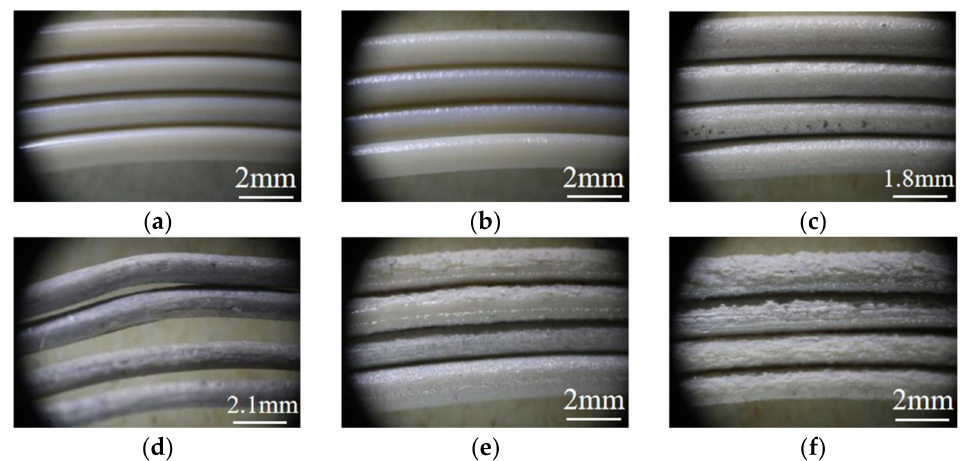
Figure 2. The morphology of the filament corresponding to each sample. The filament corresponds to the following samples: ( a ) Sample 1#; ( b ) Sample 2#; ( c ) Sample 3#; ( d ) Sample 4#; ( e ) Sample 5#; ( f ) Sample 6#.